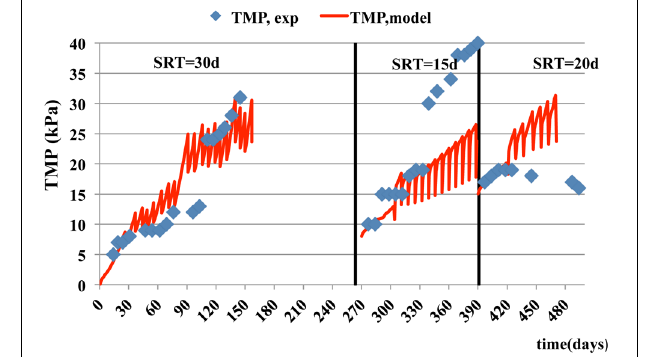
FIGURE 5 | Experimental data and model estimations of particulate EPS concentration per mass of MLVSS.